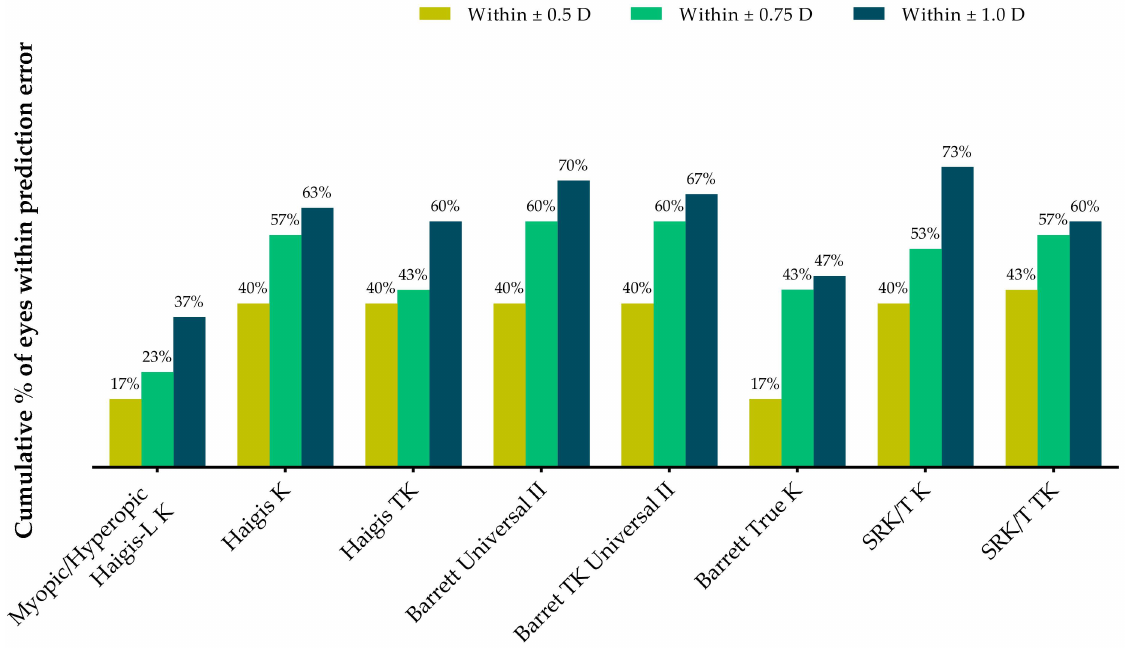
Figure 3. Stacked histogram comparing the proportions of eyes within ± 0.25 D, ± 0.50 D, and ± 1.00 D of the predicted postoperative spherical equivalent refraction at 2 months after